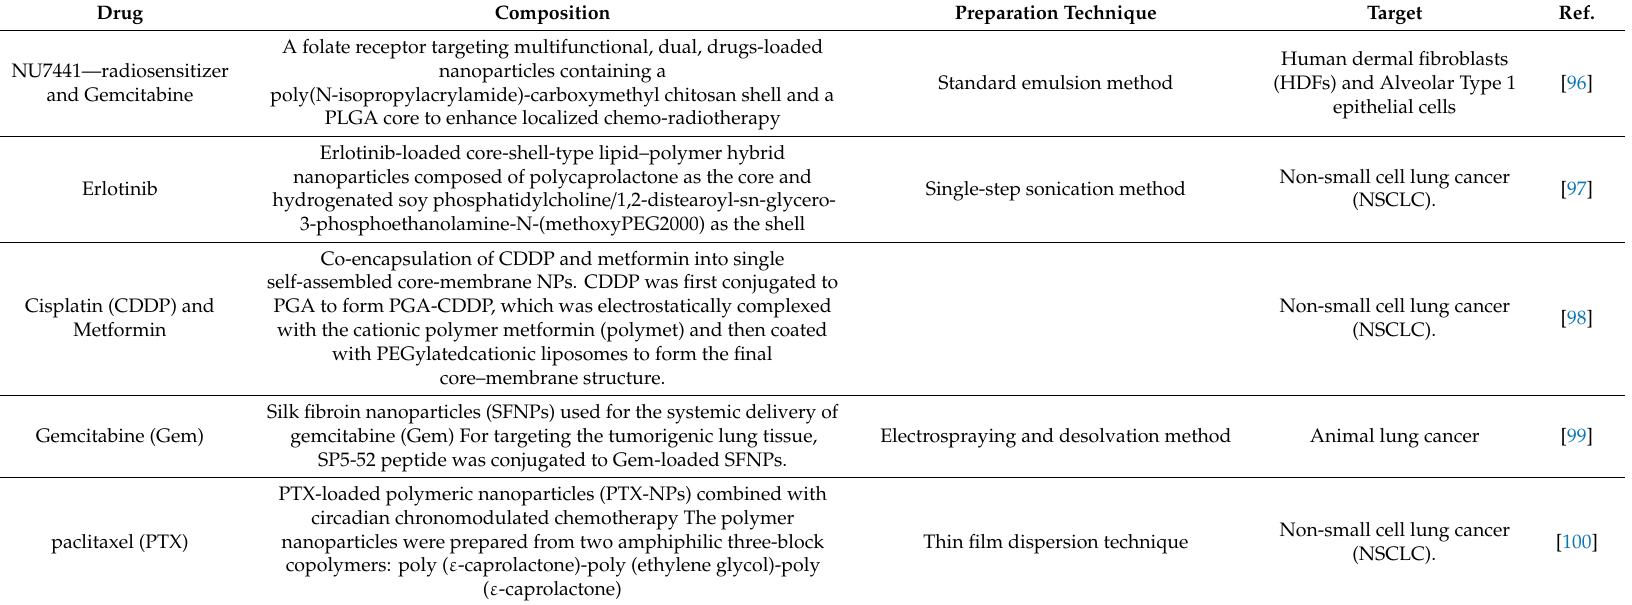
Table 3. Polymeric nanoparticles encapsulating di ff erent types of drugs for the treatment of lung cancer.